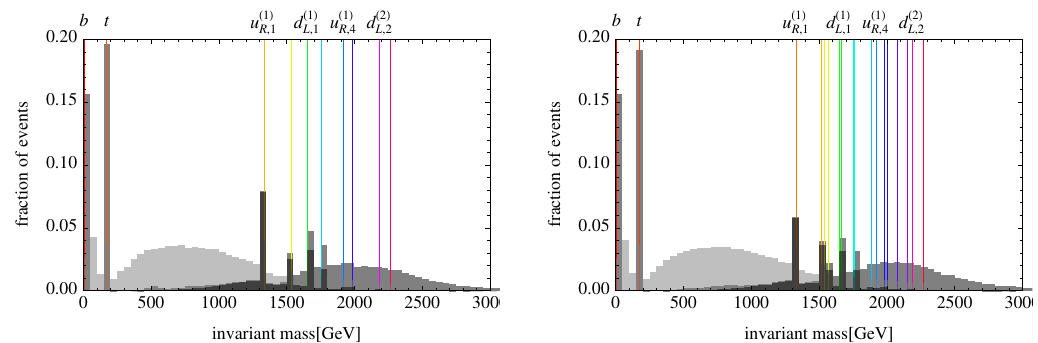
Figure 17 . Invariant mass spectrum of individual pseudojets clustered using the hemisphere algo- rithm applied to partonic gear pair production and decay at the 13 TeV LHC for model benchmarks 1 (left plot) and 2 (right plot). The original hemisphere clustering results, using the two highest invariant mass objects as seeds, are shown in light gray. Our modi(cid:12)ed hemisphere clustering re- sults, which use two heavy (cid:13)avored quarks as seeds, are shown in mid-gray. Finally, the modi(cid:12)ed hemisphere clustering results, where in addition the masses of the two pseudojets are required to di(cid:11)er by less than 30%, are shown in dark gray. The spectral lines corresponding to the actual gear masses are ovelaid in the same colors as in (cid:12)gures 15 and 16 with a subset of gear labels printed on the top. See main text for